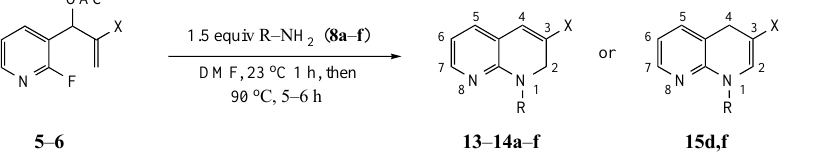
Table 2. Synthesis of 3-substituted 1-alkyl/phenyl-1,2 and 1,4-dihydronaphthyridines.